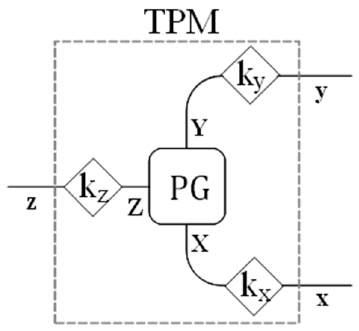
Figure 5. Scheme of a three-port mechanism with one PG (rounded-corner square) and three OGs (rhombi) realizing the k j fixed ratio.